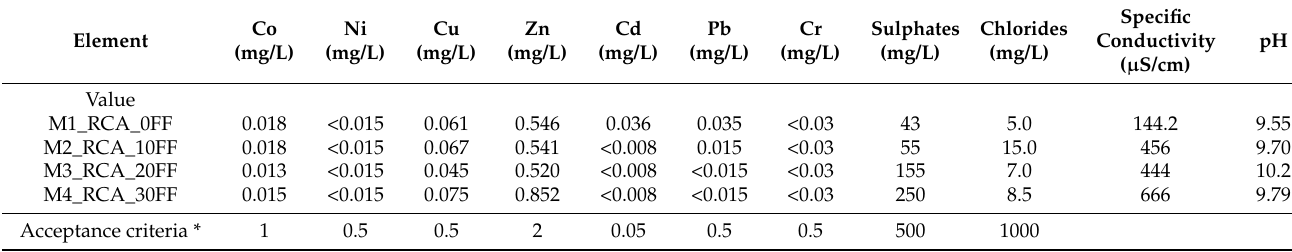
Table 6. Leachate concentration from RCA mixtures.